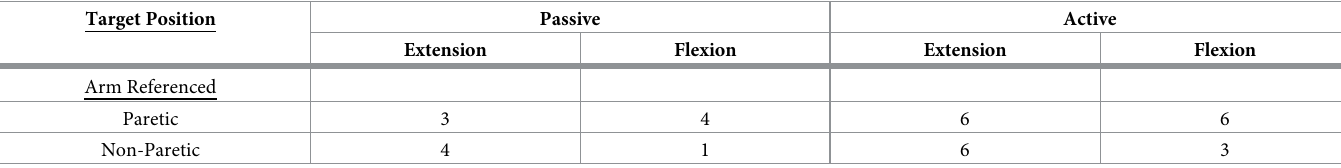
were classified as having a deficit during the passive movements and eight during the active movements. Stroke 2, 6, and 11 were identified as having intact perception during the passive movements, yet a deficit during the active movements. Stroke 9 was identified as having a defi- cit during the passive movements, yet intact perception during the active movements. The remainder of the participants were classified as having either only a deficit or only intact per- ception for both modes of limb control. The passive threshold error was 8.2˚. Hence, participants with stroke who had an absolute error greater than this passive threshold error during one of the four testing scenarios, i.e. referencing either arm at the extension or flexion reference target position, were classified as having a passive position-mirroring deficit. Table 2 summarizes the testing scenarios which resulted in the six participants being classified as having a deficit. We point out that the num- ber of testing scenarios which can contribute to participants being classified as having a deficit Table 2. Testing scenarios for which participants were classified as having a deficit. Summarized are the number of incidences when referencing each arm at each target position for which participants were classified as having a deficit when their forearms were passively rotated and actively controlled. Target Position